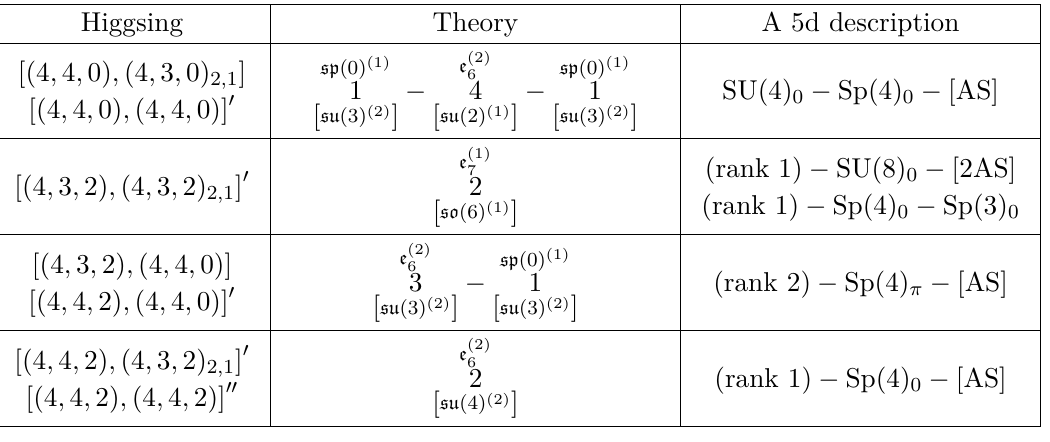
(cid:0) (cid:1) (cid:0) (cid:1) SU(4) 2 × SU(2) × SU(4) 2 × SU(2) of (2.64). The table algebra. The other cases 7